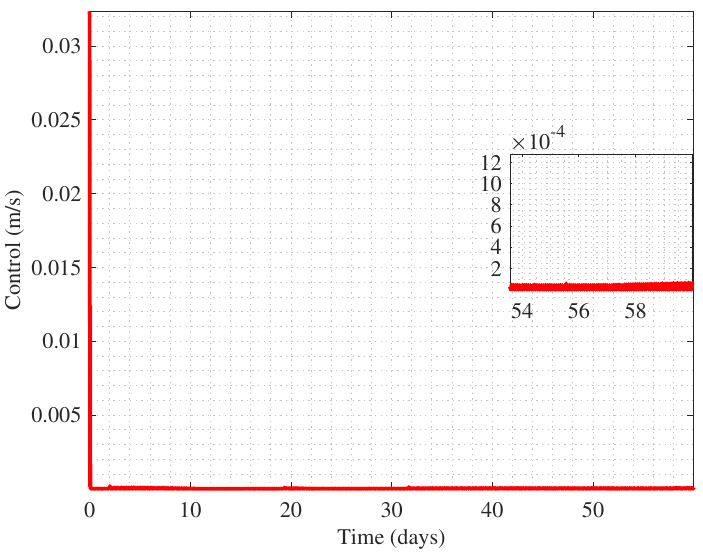
Figure 10. Control effects changing with time.